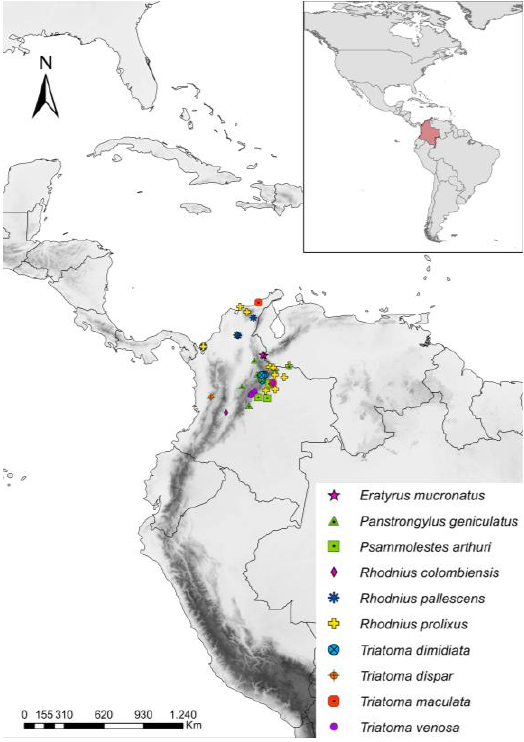
Figure 1. Distribution of triatomines per species collected in the field across 13 departments of Co- lombia. The map was made using ArcGIS (Software) v10.2 (ESRI, 2014). Colombia. The map was made using ArcGIS (Software) v10.2 (ESRI,